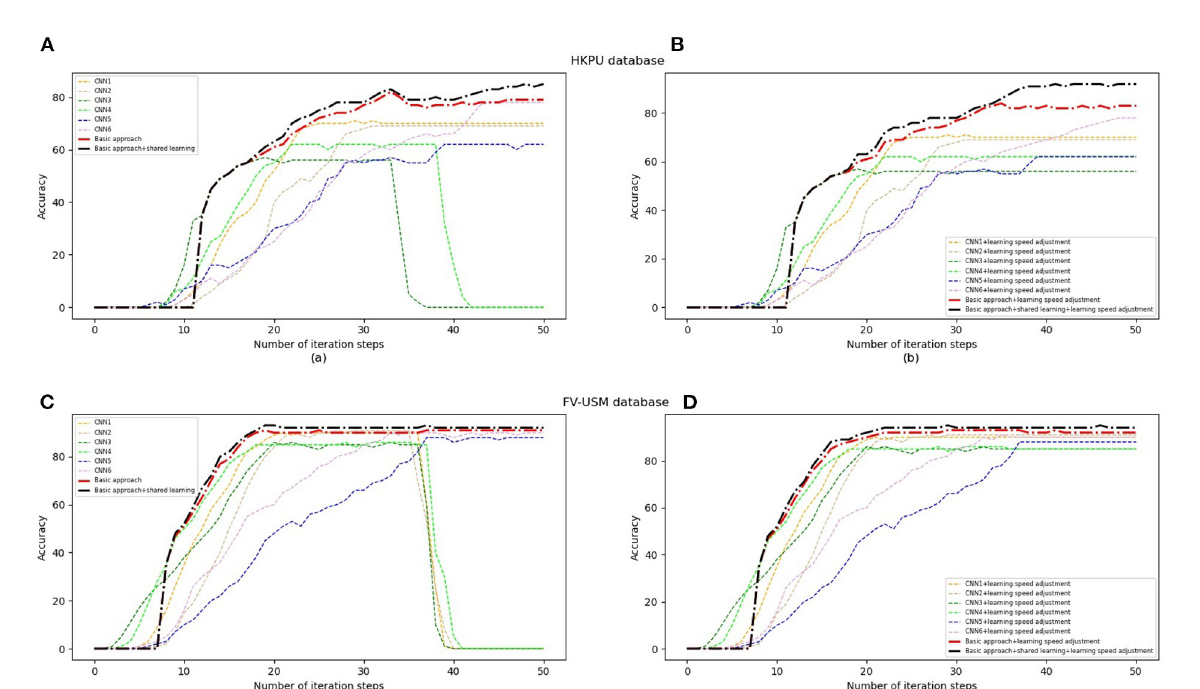
FIGURE11 Performance of various classifiers with learning speed adjustment. (A) The performance of all our approaches on the HKPU database without adjusting learning speed. (B) The performance of all our approaches+adjust learning speed on the HKPU database. (C) The performance of all our approaches on the FV-USM database without adjusting learning speed. (D) The performance of all our approaches+adjust learning speed on the FV-USM